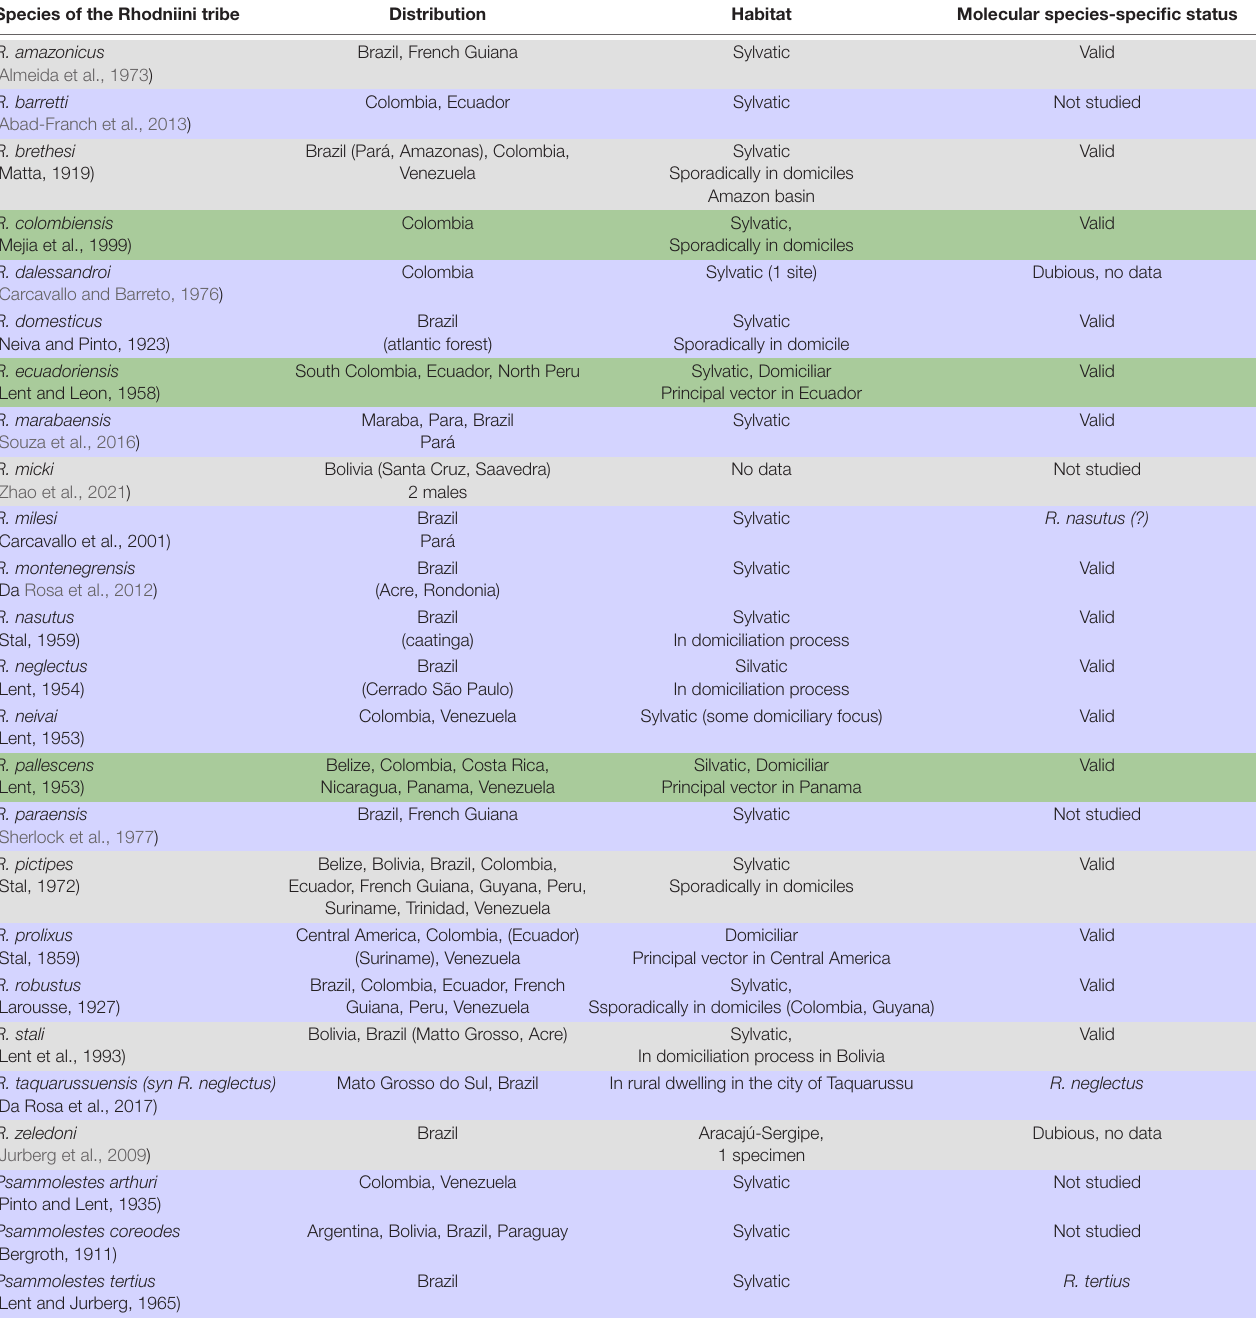
TABLE 1 | Distribution and habitat of the species of the Rhodniini tribe and molecular species-specific status inferred from this study. Species of the Rhodniini